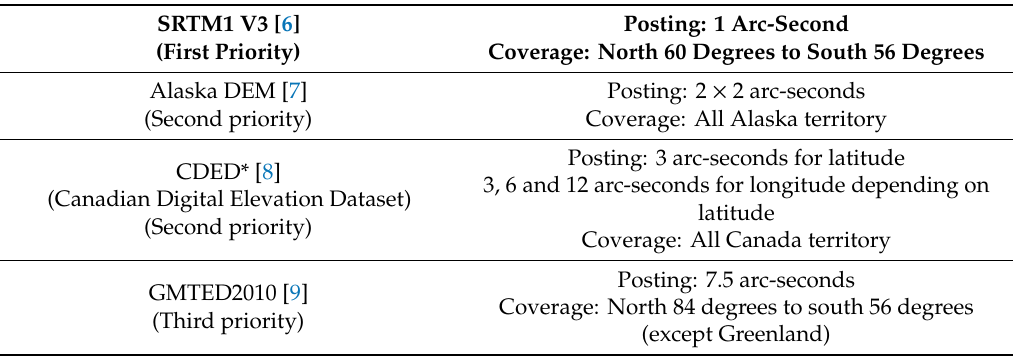
Table 1. Reference digital elevation model (DEM)